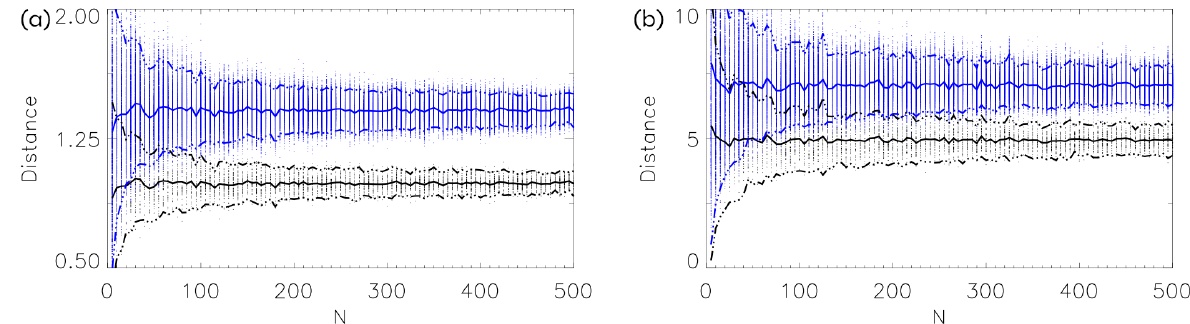
Figure 4. The normalized distances as a function of dimension N . For each N we draw 50 N -dimensional random vectors and calculate the (cid:112) || (cid:112) || x k − x l || 2 /N (blue) and the distances to the sample mean x k − x || 2 /N (black). The thick curves show the mean pairwise distances of the distances and the broken curves the mean ± 2 standard deviations. In (a) each component of the vectors is drawn from a standard Gaussian; in (b) each component is drawn from a standard Gamma distribution with shape parameter 3 (location and scale parameters 0 and 1). In the latter case we include anisotropy by multiplying the n th component by 5 n/N , so the mean and variance of the n th